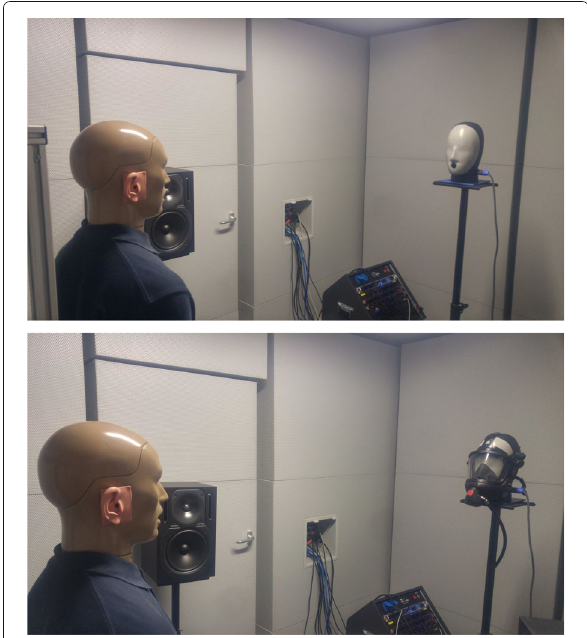
Fig. 16 Evaluation setup with and without mask and communication system passive mask and the mask with activated communication